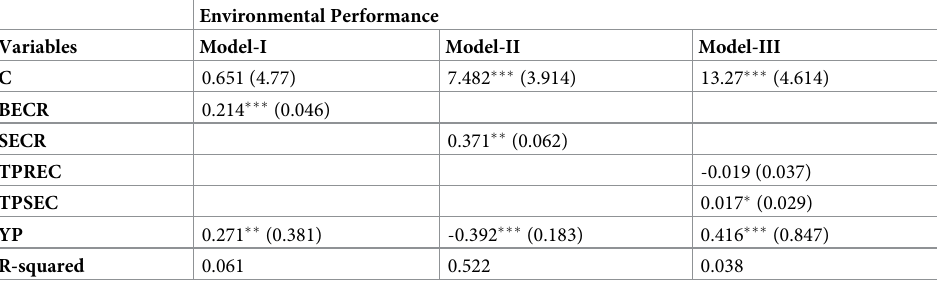
Table 3. Impact of economic reforms on environmental